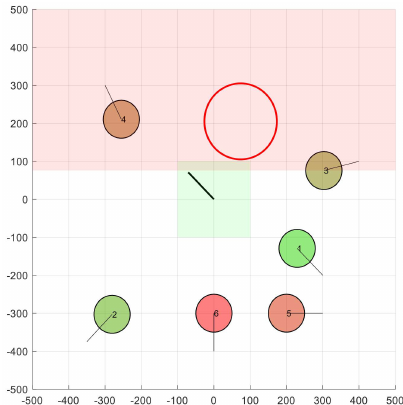
Figure 5. Extension of the obstacle produced by node 3 according to the velocity vector of node